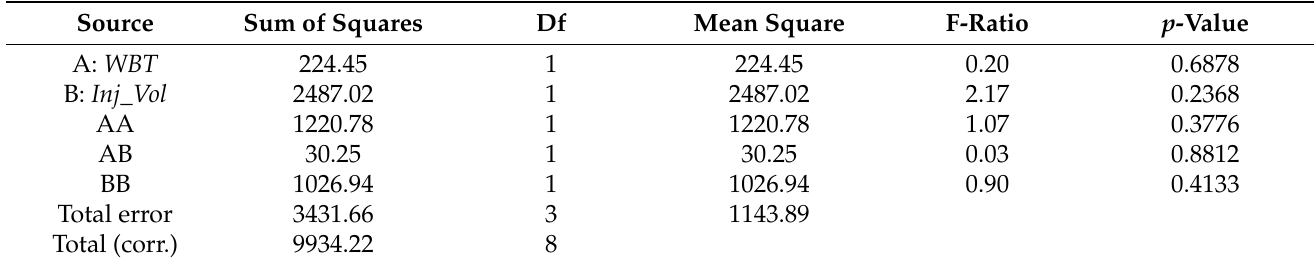
Table 5. Analysis of Variance for the restart time of the gradual injection model.